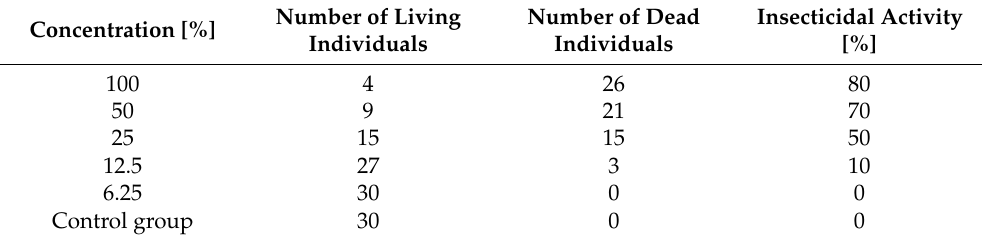
Table 12. Anti-Insect activity of OBEO. Concentration [%]